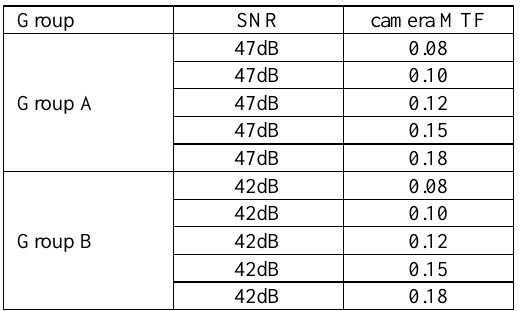
Table 2. Two group testing results